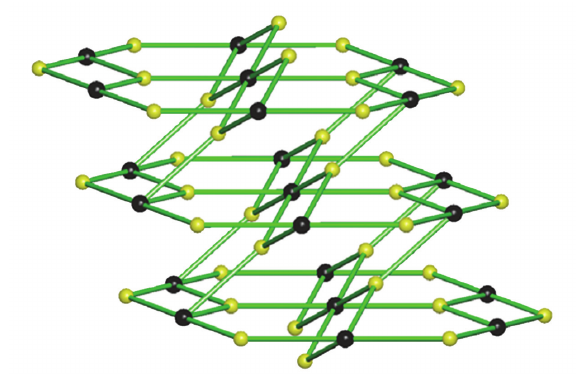
Figure 8: A view of the binodal 3D hydrogen-bonded rtl - (4.6 2 ) 2 (4 2 .6 10 .8 3 ) net that 1 adopts. Black spheres represent the 6-connected [Co(DEU) 6 ] 2+ cations and yellow spheres the 3- connected BF 4 −